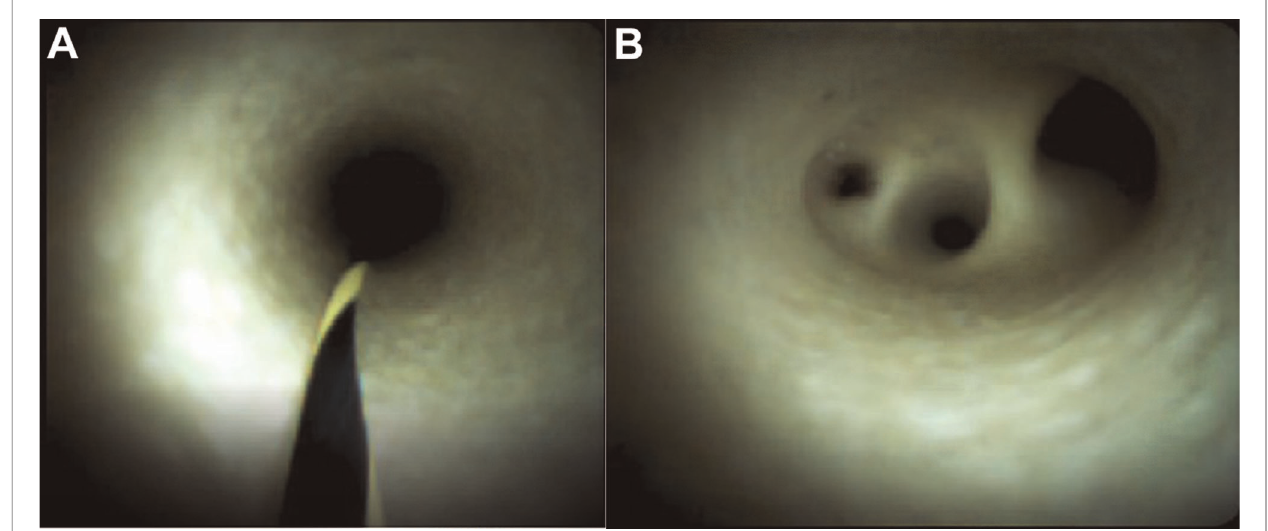
FIGURE 7 | Bile Duct ( A ) and Porta Hepatis Bile Duct ( B ) Observed with SpyGlass ™ .